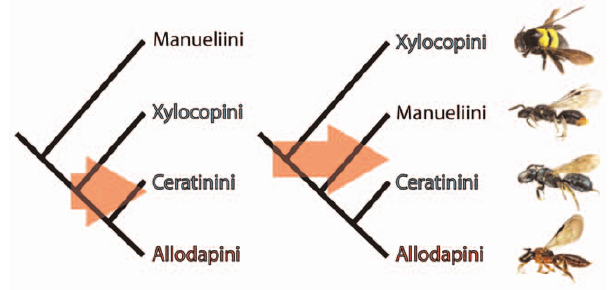
Figure 1. Alternative scenarios of carpenter bee relationships with likely implications for origins of sociality. Studies conflict over whether Manueliini or Xylocopini is the most basal tribe the Xylocopinae. All allodapines are social and most ceratinines and xylocopines are social, whereas the only two well-studied species of Manuelia are solitary. A Manueliini-basal phylogeny (left) would make it more likely that sociality is not the ancestral state for the subfamily as well as imply a more recent origin of sociality. Arrows contrast the possible ranges in timings of social origins, but more than one origin is still possible under both